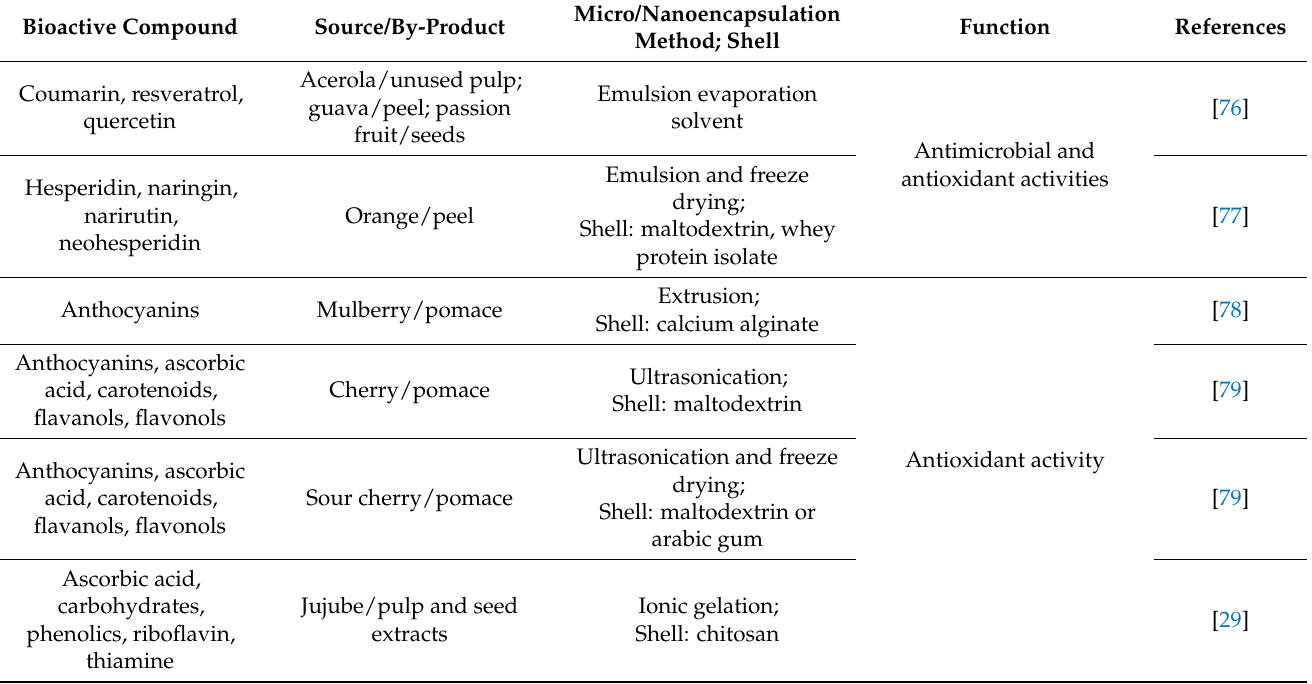
Table 3. Micro- and nanoencapsulated bioactive compounds from agro-industrial by-products for the shelf-life extension of food